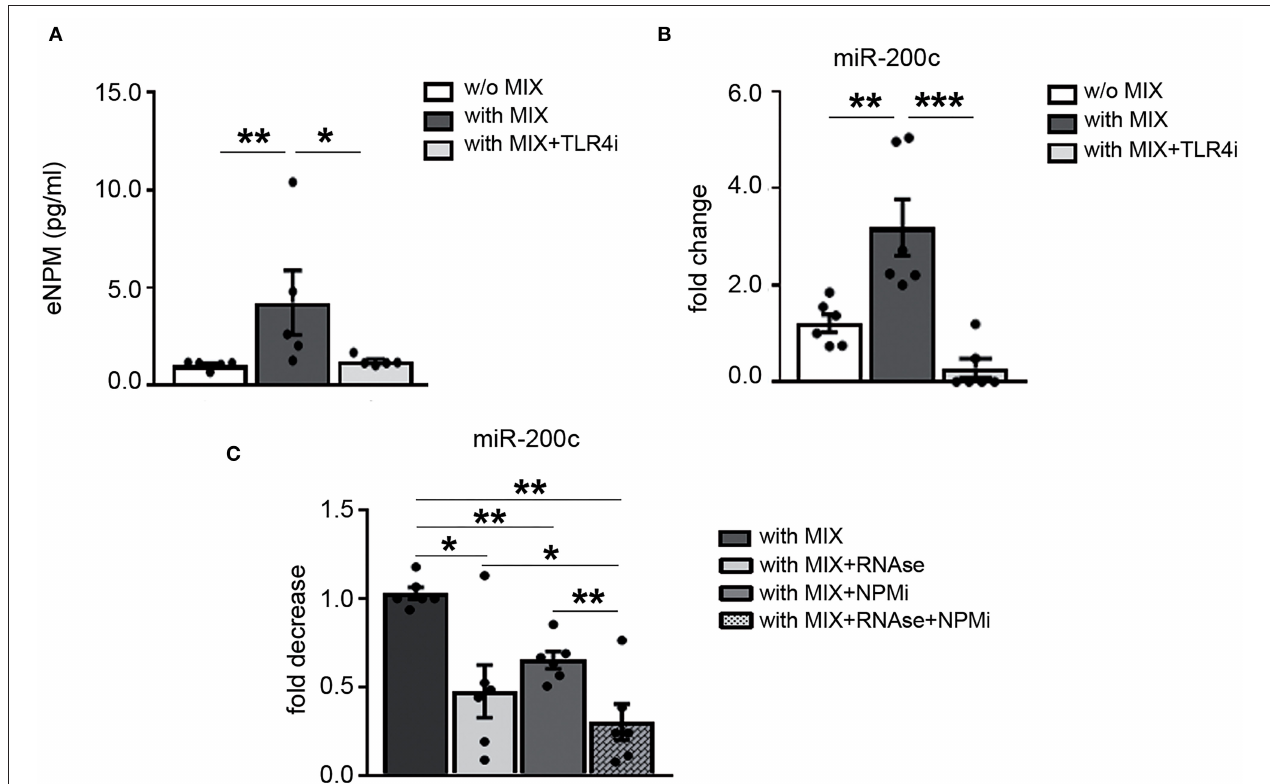
FIGURE 6 | TRL4-based mechanism regulates NPM and miR-200c secretion in response to cytokine mix and miR-200c and NPM physically interact. HaCaT were pre-treated with 100 µ M TLR4i for 30min and then treated or not for 8h with cytokine MIX (IL-17A, IL-22, TNF- α , and IFN- γ ). (A) Media were collected and analyzed by ELISA assay for the presence of eNPM. eNPM increased levels by cytokine MIX were significantly decreased by TLR4i ( n = 5; * p < 0.05; ** p < 0.01). (B) qRT-PCR of miR-200c from the supernatant show that miR-200c increase elicited by cytokine MIX treatment is significantly reduced by TLR4i ( n = 6; ** p < 0.01; *** p < 0.001). (C) HaCaT were treated with cytokine MIX for 8h then supernatants were collected and treated either with RNase or 200 µ M NPM inhibitor (NPMi) or 2 µ g/ml RNAse together with 200 µ M NPMi for 15 min at 37 ◦ C ( n = 6, * p < 0.05; ** p < 0.01).